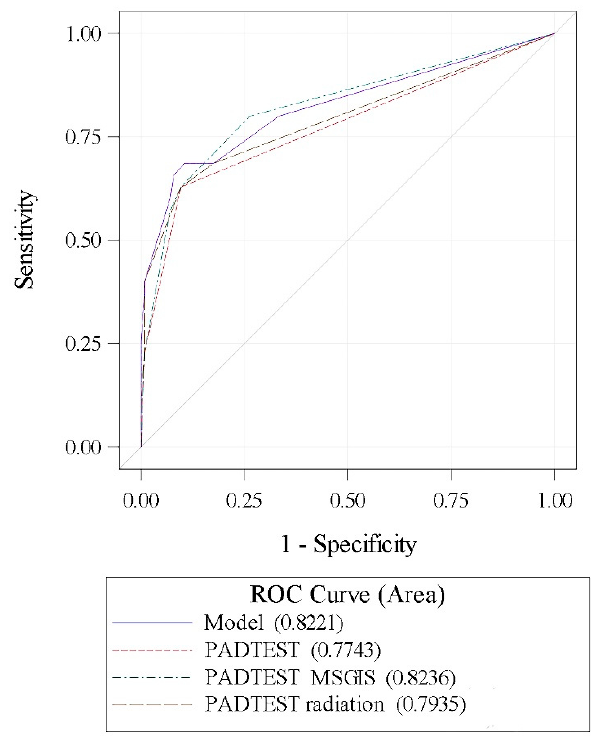
Figure 3. ROC curves for comparisons.